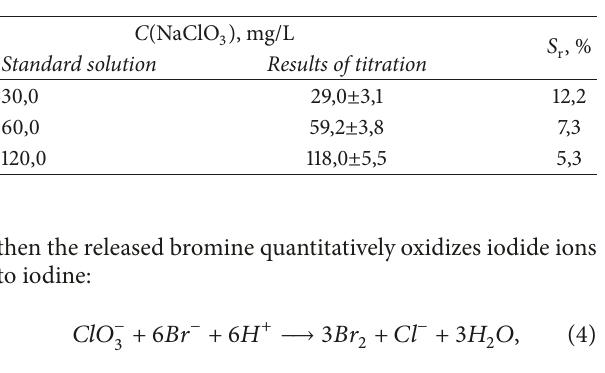
Figure 1: The dependence of the determined concentration of NaClO 3 inthestandardsolutiononthereactiontimebeforetitration with blank correction. The standard solution, mg/L: 30.0 (curve 1), 60.0 (curve 2), 120.0 (curve 3).